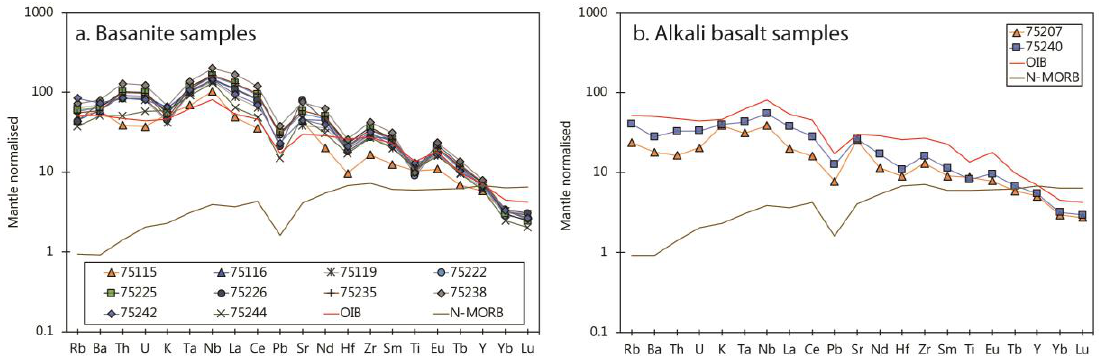
Figure 2. Trace element variation diagrams, normalised to primitive mantle compositions, for the basanites ( a ) and alkali basalts ( b ) from the Buckland volcanic province.